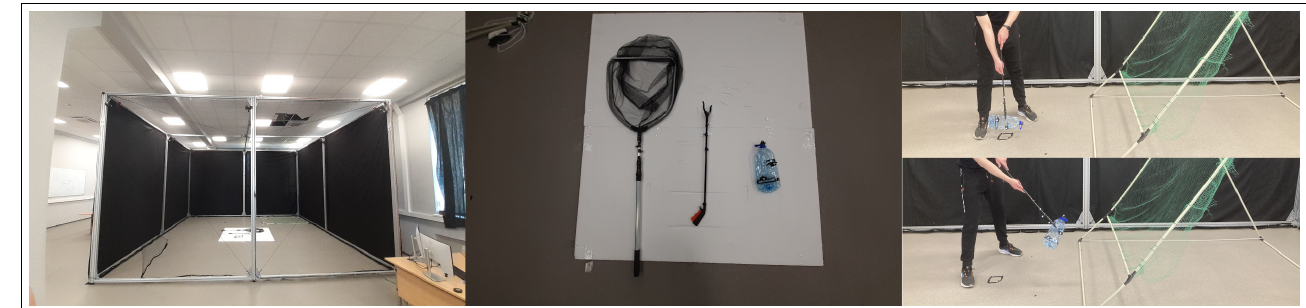
Figure 2. Motion capture equipment and demonstration acquisition